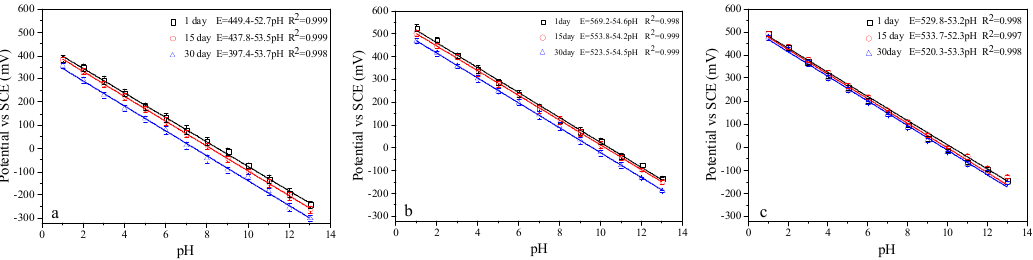
Figure 6. Long-term stability of IrO X pH electrodes fabricated at 750 °C ( a ), 800 °C ( b ), and 850 °C ( c ).